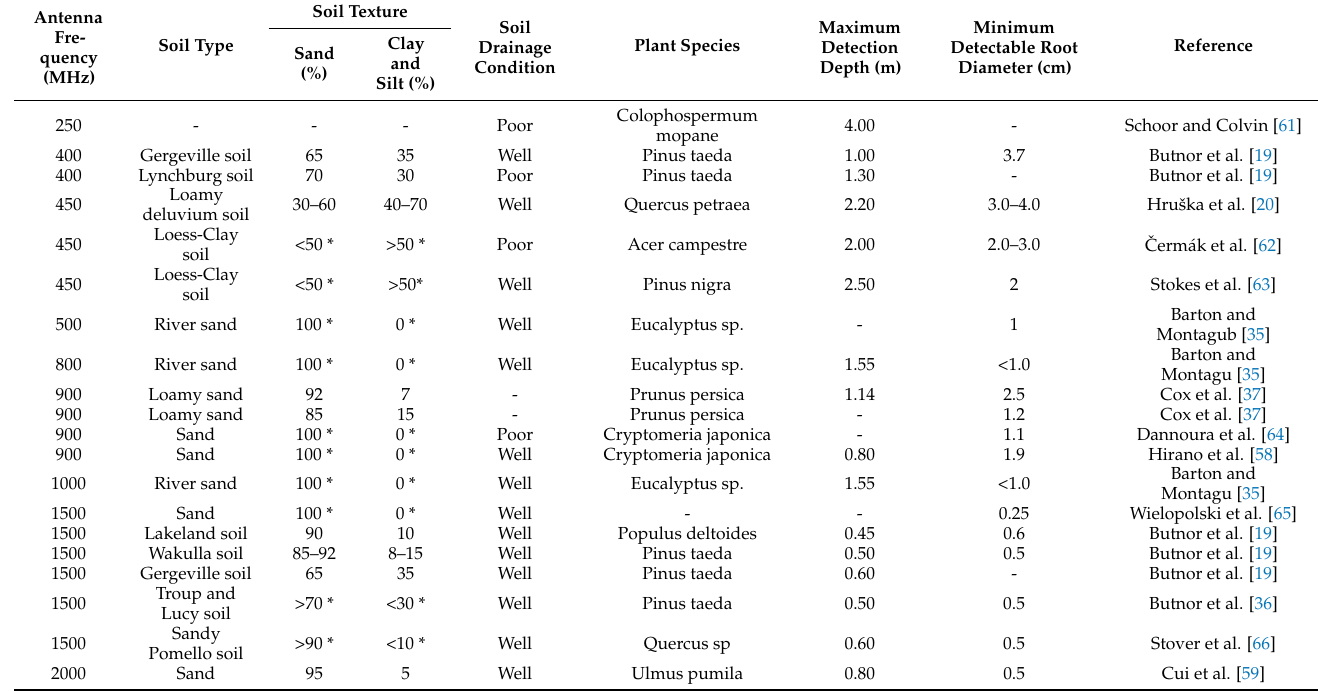
Table A1. The maximum effective detection depth and minimum detectable root size of GPR systems with different radar frequencies used for root detection in various soil types